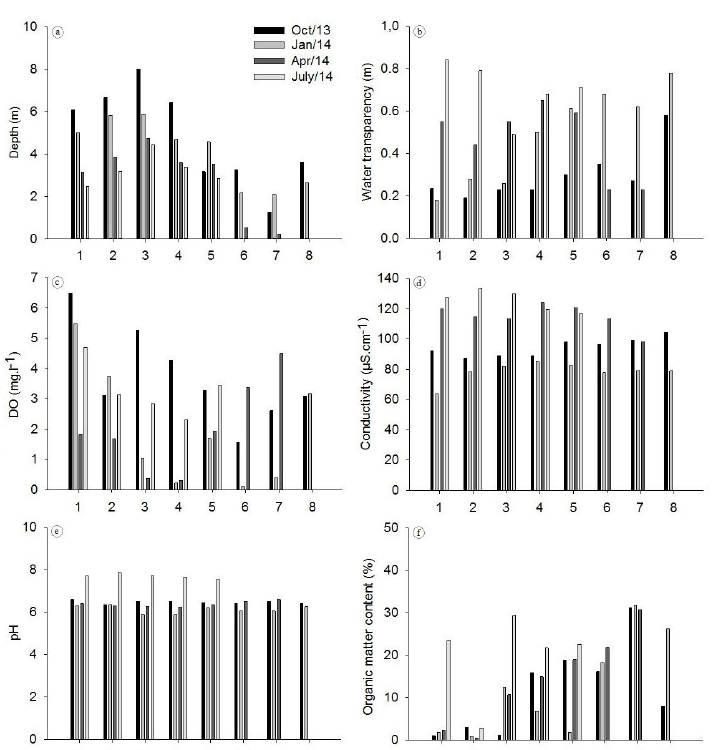
Figure 3. Temporal and spatial variation of depth (m) (a), water transparency (by Secchi disk) (b), dissolved oxygen (DO) (c), conductivity (d), pH (e) and organic matter in sediment (f) on the Guareí River (1-4) and the lateral area (5-8) in October 2013, January, April and July